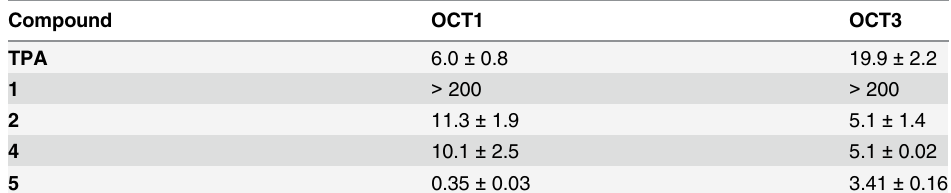
Fig 8. Concentration-dependent inhibition of ASP + -uptake by OCT expressing HEK-cells. Inhibition of ASP + -uptake (1 μ M) into HEK-OCT1 (A) and HEK-OCT3 (B) cells by TPA, 2 , 4 or 5 . The mean fluorescence intensities were normalized to uninhibited ASP + -uptake (N = 3). doi:10.1371/journal.pone.0133743.g008 Table 2. Inhibition of ASP + -uptake into HEK-OCT1 and HEK-OCT3 cells. IC 50 ( μ M) values ± SEM (N = 3).